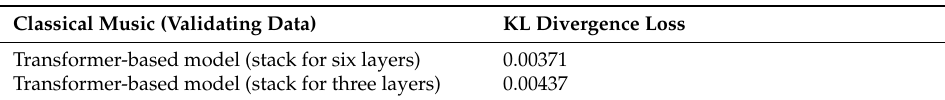
Table 4. Results with classical music